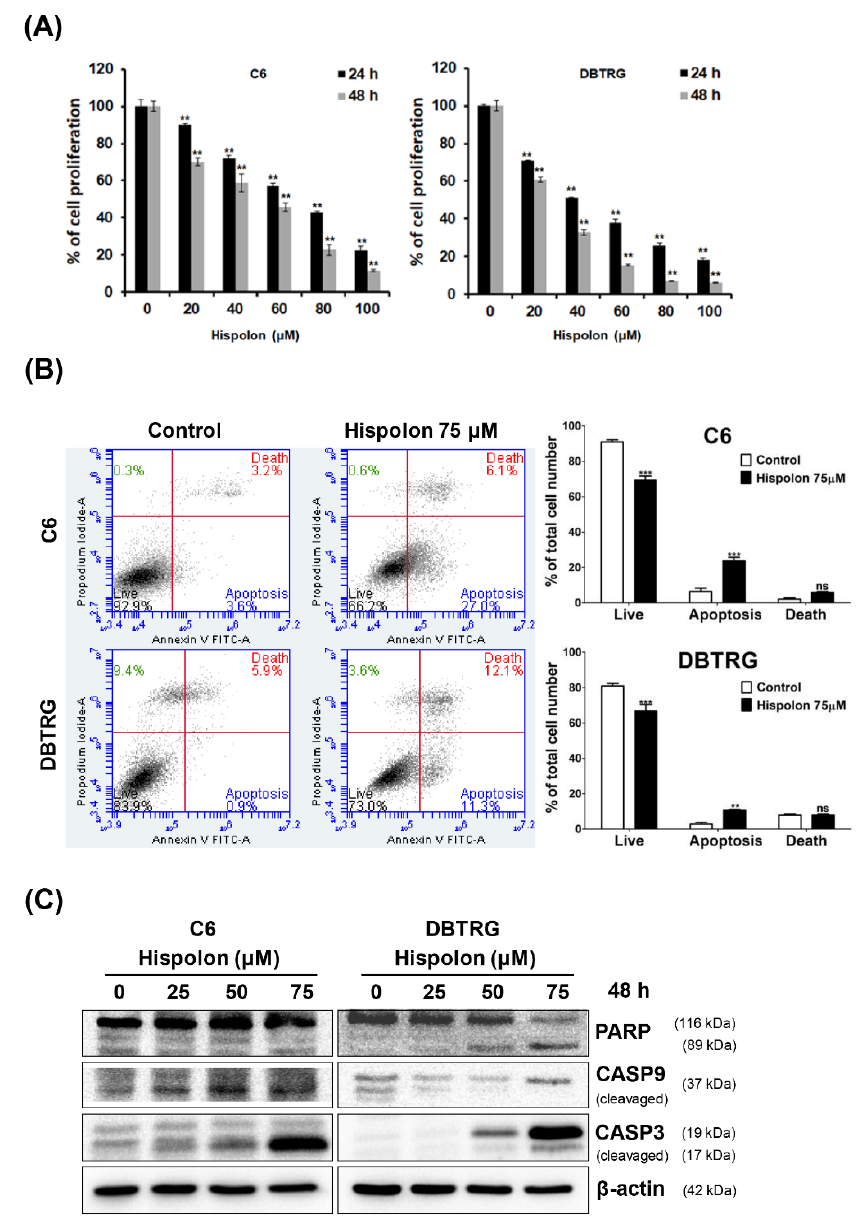
Figure 1. Hispolon inhibited cell proliferation and induced cell apoptosis in GBM cells. ( A ) GBM cells were treated with different concentrations of hispolon (0–100 μ M) for 24 or 48 h, and the cell viability was detected through MTT assay. ( B ) GBM cells were treated with 75 μ M hispolon for 24 h and then subjected to annexin V-FITC staining followed by flow cytometry analysis. ( C ) GBM cells were treated with different concentrations of hispolon (0–75 μ M) for 48 h and subjected to Western blot analysis with antibodies against PARP, cleaved caspase-3, and cleaved caspase-9. Data are presented as mean ± SD. ** p < 0.01 versus vehicle and *** p < 0.001 versus vehicle, ns: not significant.